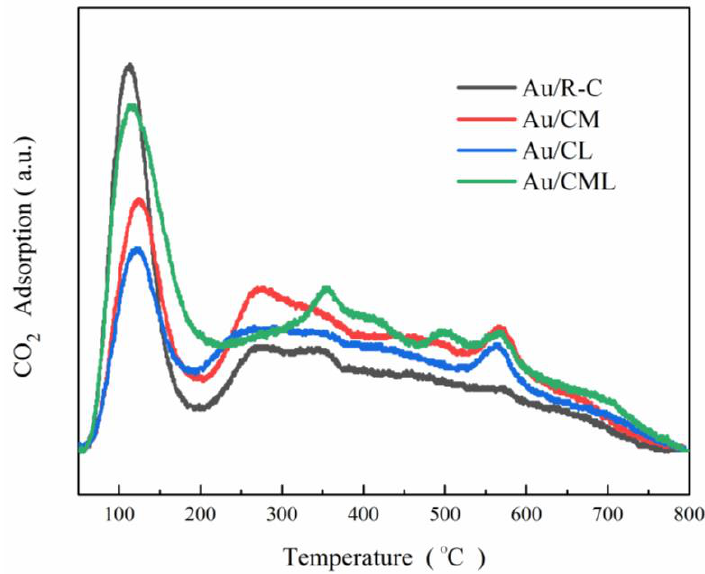
Figure 7. CO 2 - TPD profiles of the prepared catalysts . Figure 7. CO 2 -TPD profiles of the prepared catalysts.